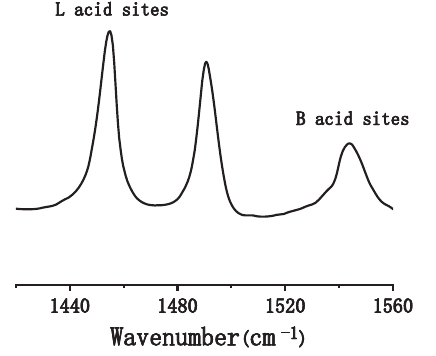
Figure 4: Pyridine FT - IR spectra of TUD - 1.